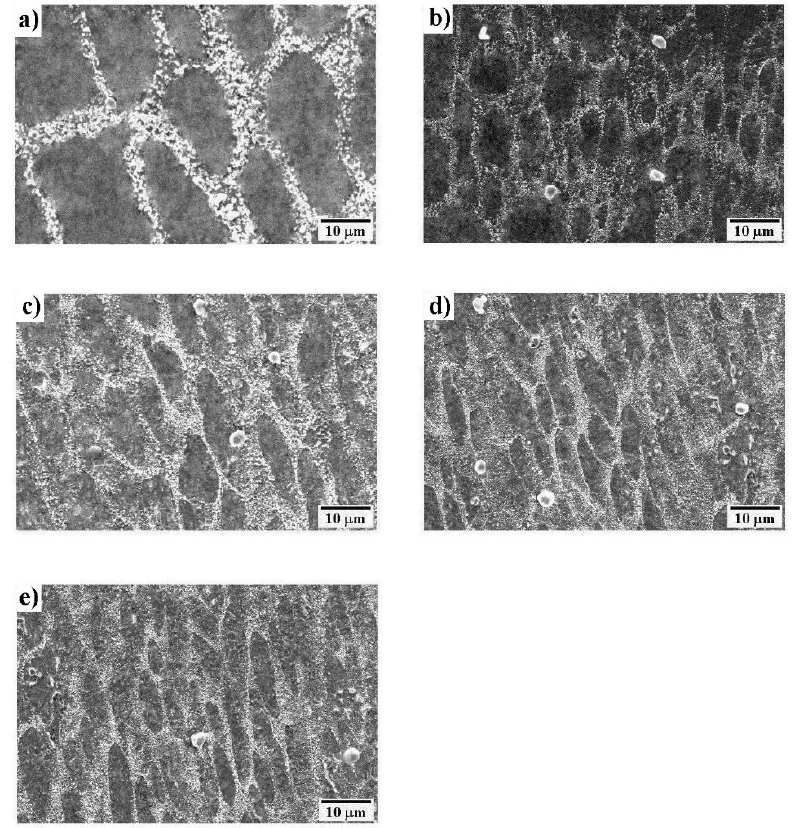
Figure 9. Representative SEM micrographs of the SAC105-Bi solders aged at 413 K ( a ) SAC105, ( b ) SAC105-0.5Bi, ( c ) SAC105-1.5Bi, ( d ) SAC105-2.5Bi, and ( e ) SAC105-3.5Bi solders.